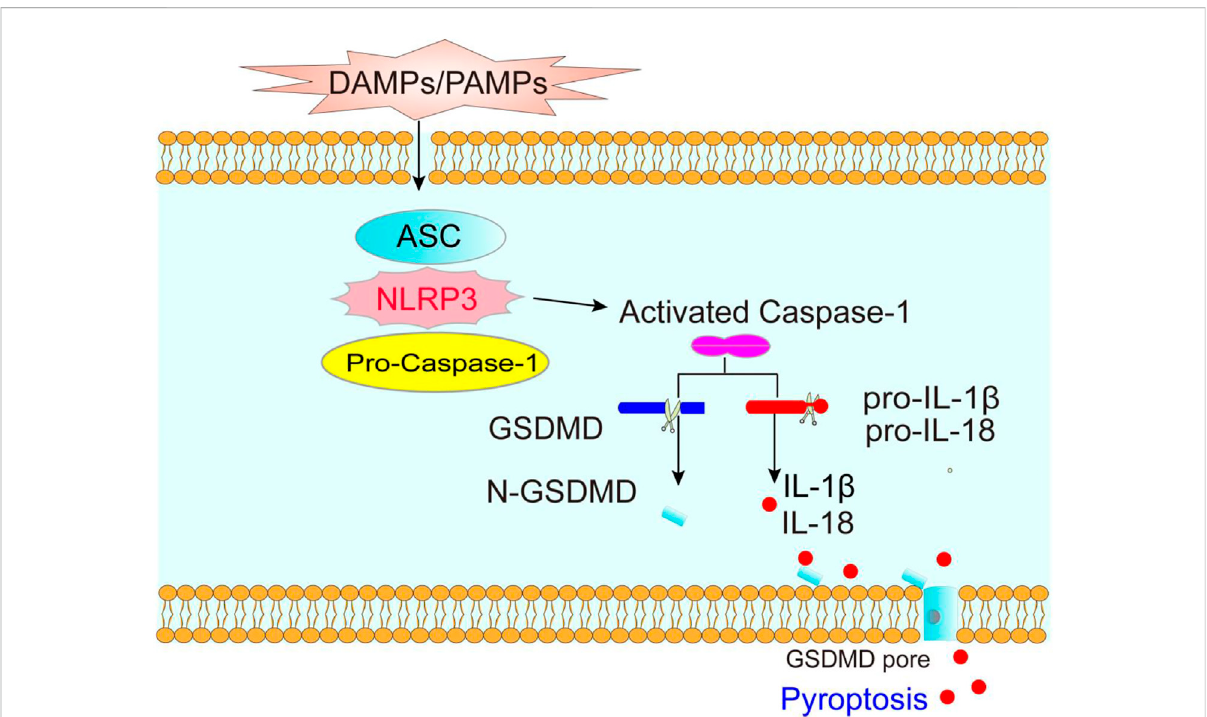
The molecular mechanism of pyroptosis. DAMPs (danger-associated molecular patterns) and PAMPs (pathogen-related molecular patterns) activateNLRP3in fl ammasome,promotes Caspase-1 activation,whichcleavagesGSDMDandtheprecursorofIL-1 β andIL-18,formingmature IL-1 β and IL-18, thereby causing